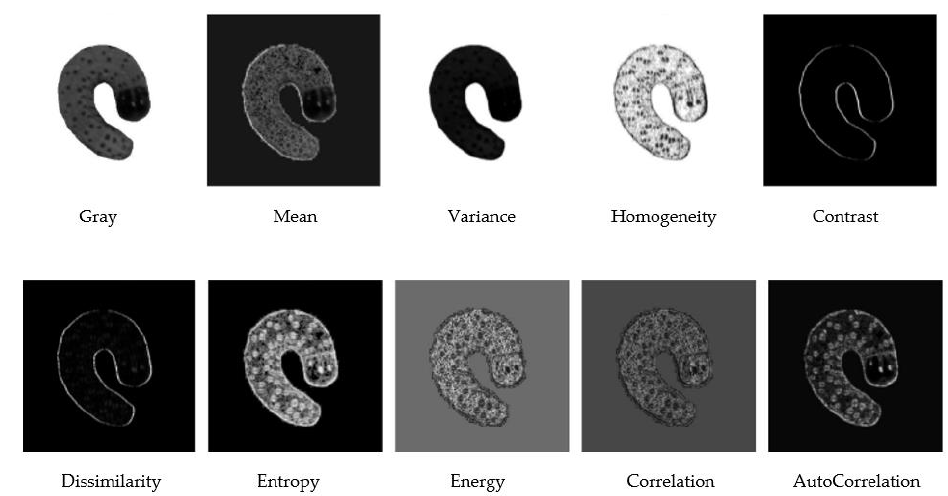
Figure 9. Nine texture feature maps of a FAW larva.